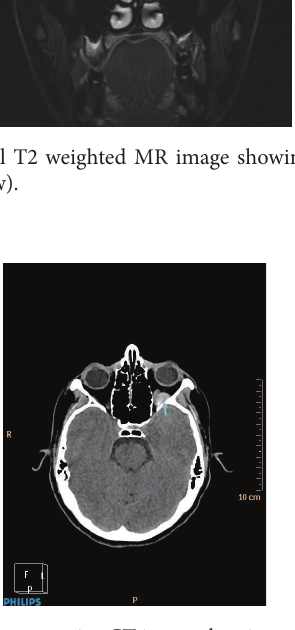
Figure 6: Axial postoperative CT image showing a small reduction in the size of haematoma